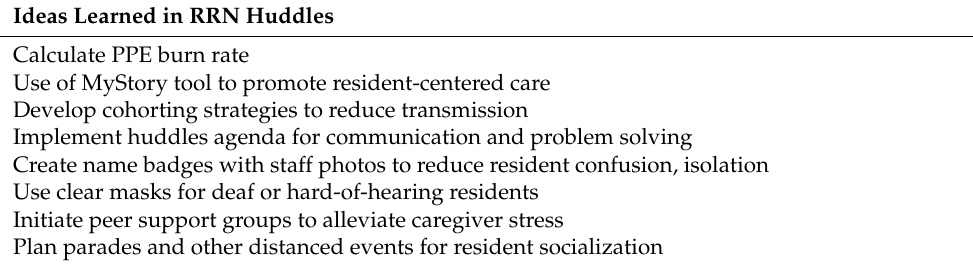
Table 4. Selection of ideas learned in huddles that participants brought to their organizations. Ideas Learned in RRN